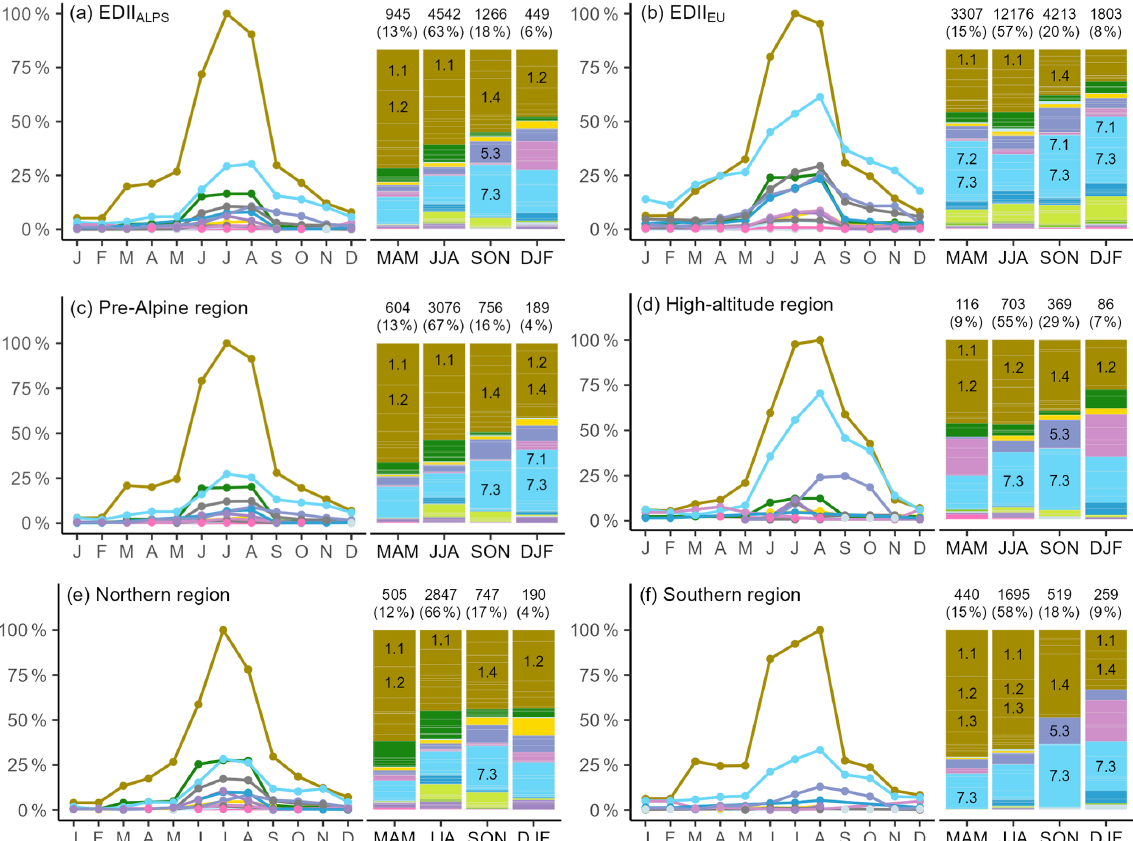
Figure 4. Annual distribution of reported impact categories per month (line diagrams) and season (bar plots) for the (a) EDII ALPS , (b) EDII EU , (c) pre-Alpine region, (d) high-altitude region, (e) northern region and (f) southern region. Monthly percentages relate to the sum of all impacts per month and the category with 100% corresponding to the month with most impacts. Total counts of each season are given on top of the bars, the fraction in parentheses relates to the number of impacts assigned to the season. Subtypes with a fraction ≥ 10% per season are labelled. For an explanation of the colours, see Fig.